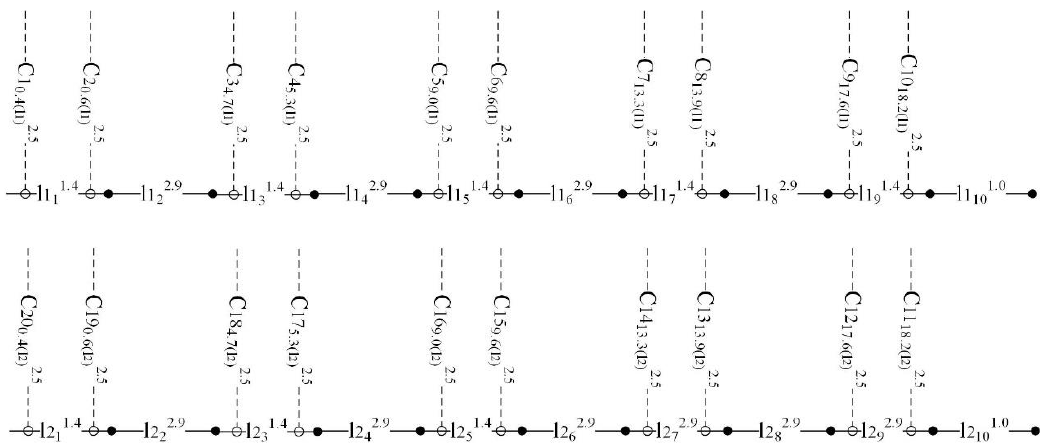
Figure 6. BHS system structure.